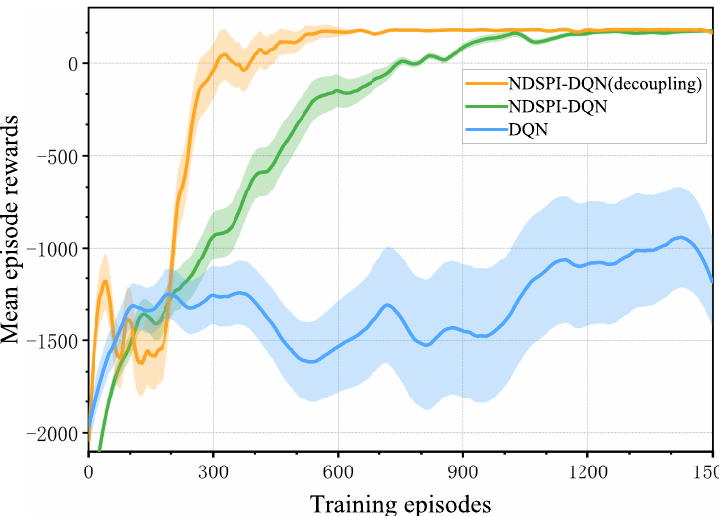
Figure 4. Mean episode rewards versus training episodes for different algorithms in scenario